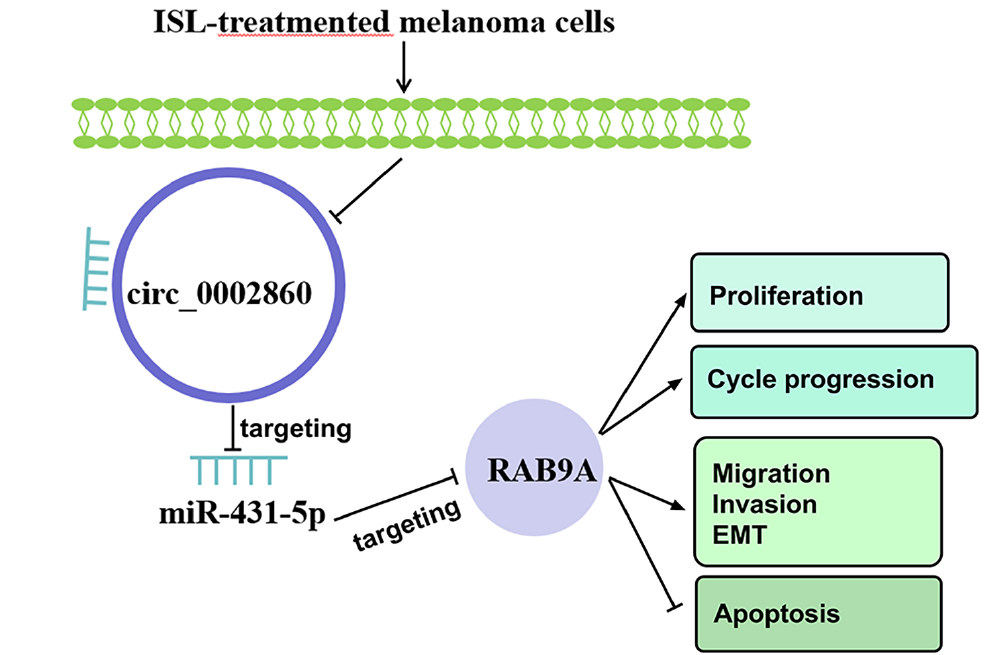
Figure 8. The mechanical diagram of ISL in melanoma